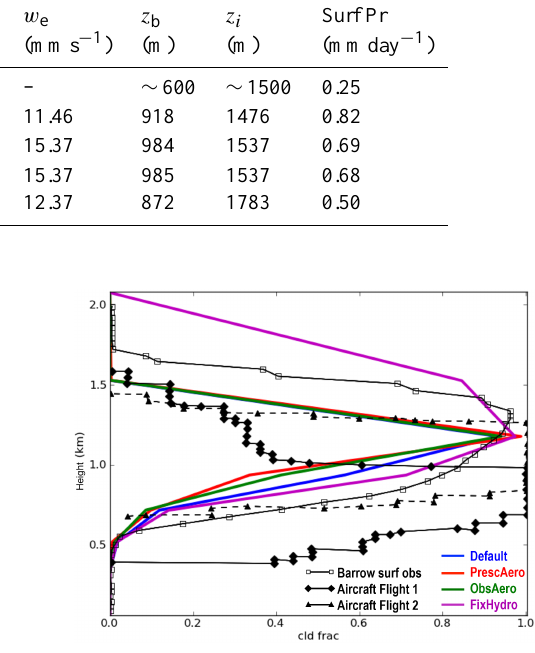
Figure 4. Profiles of in-cloud N i values for MPACE-B. GCM values are 10-year July averages extracted at the location of MPACE-B divided by 10 in order to fit in the plot.